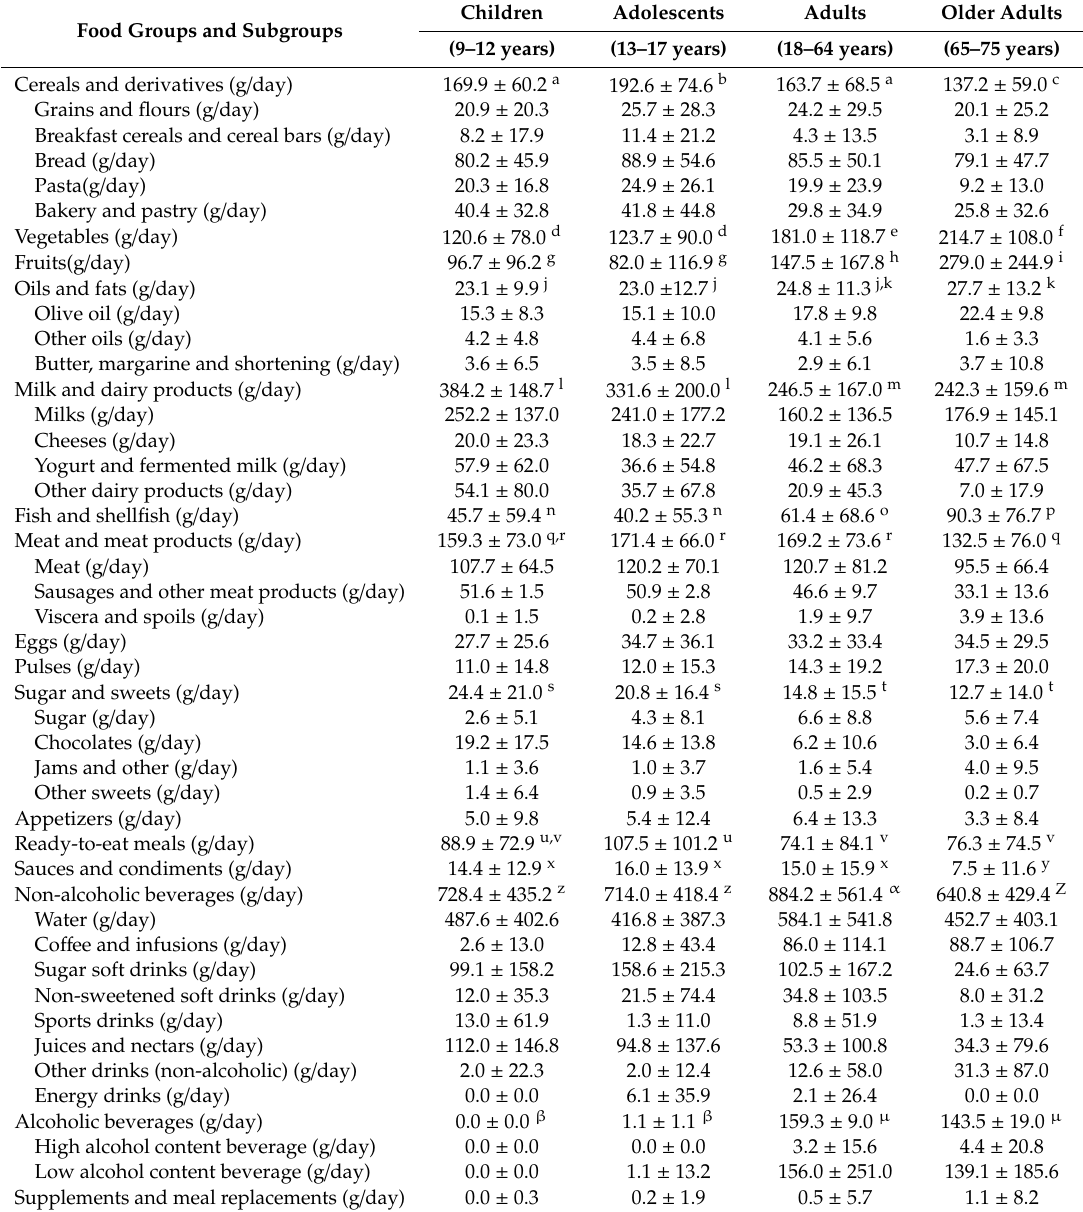
Table 4. Total daily food groups and subgroups intake by age in the male Spanish ANIBES study